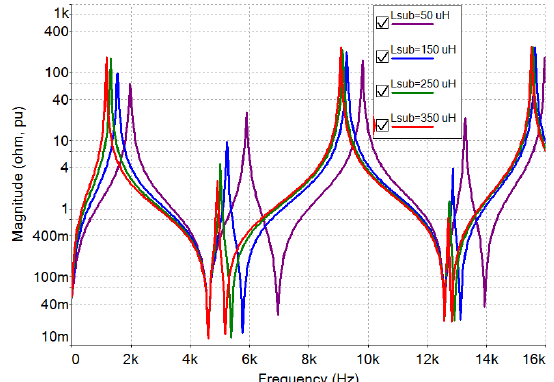
Figure 6. Magnitude of the impedance seen by the pantograph terminals as a function of the substation impedance (in ohm, pu) with the train in the middle of a section with a length of 30